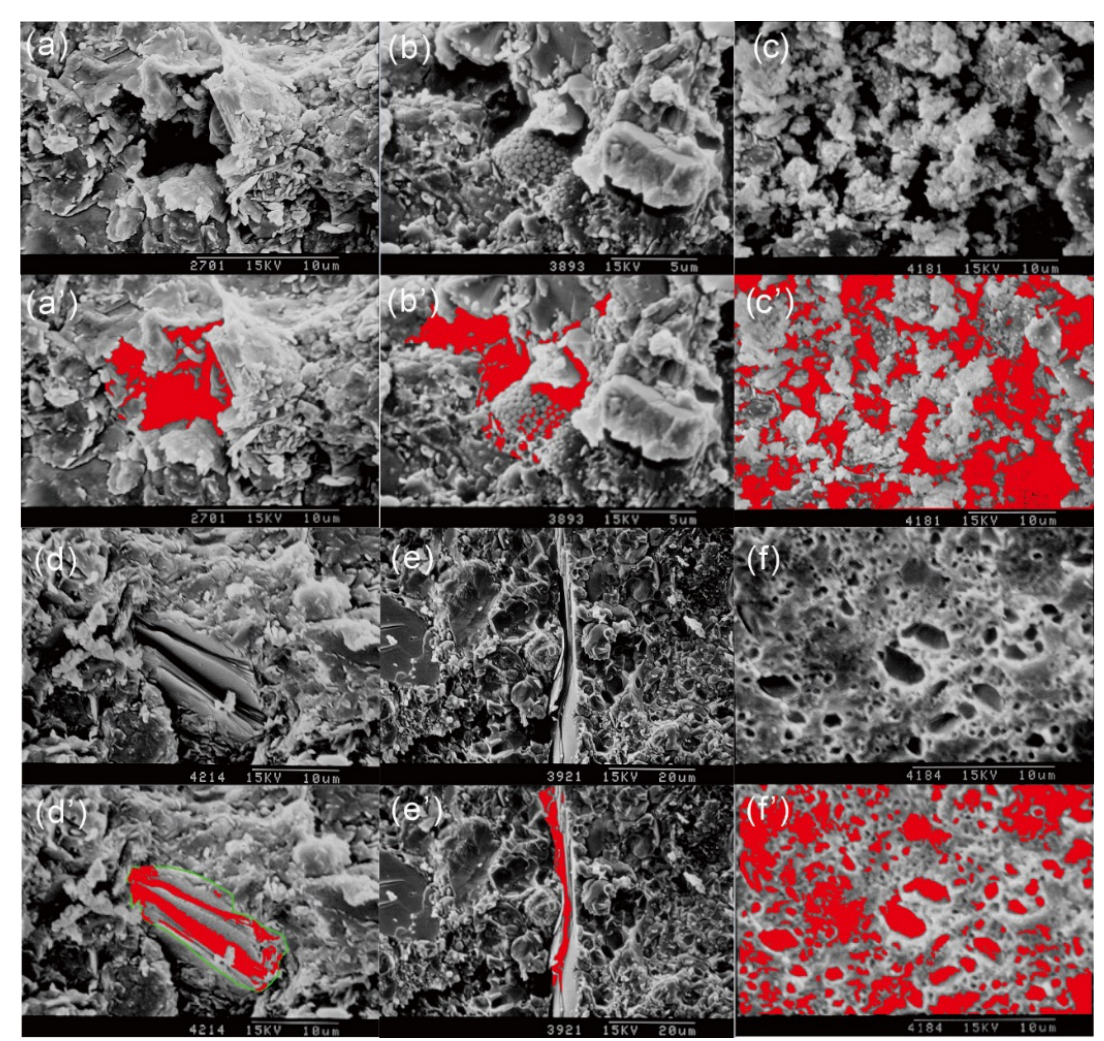
Figure 9. Extraction of pore features from shales of the Wufeng-Longmaxi and Niutitang Formations in Guizhou Province. ( a – c ) The original images of intergranular pores corresponding to “a’ to c’”; ( a ’– c ’) Extraction of intergranular pore features, ( d , e ) The original images of intergranular microfractures corresponding to “d’ to e’”; ( d ’, e ’) extraction of intergranular microfracture features; ( f ) The original images of dissolution pores corresponding to “f’’; ( f ’) extraction of dissolution pore features. Table 10. The plane porosity of the intergranular pores in the Wufeng-Longmaxi Formation and Niutitang Formation.